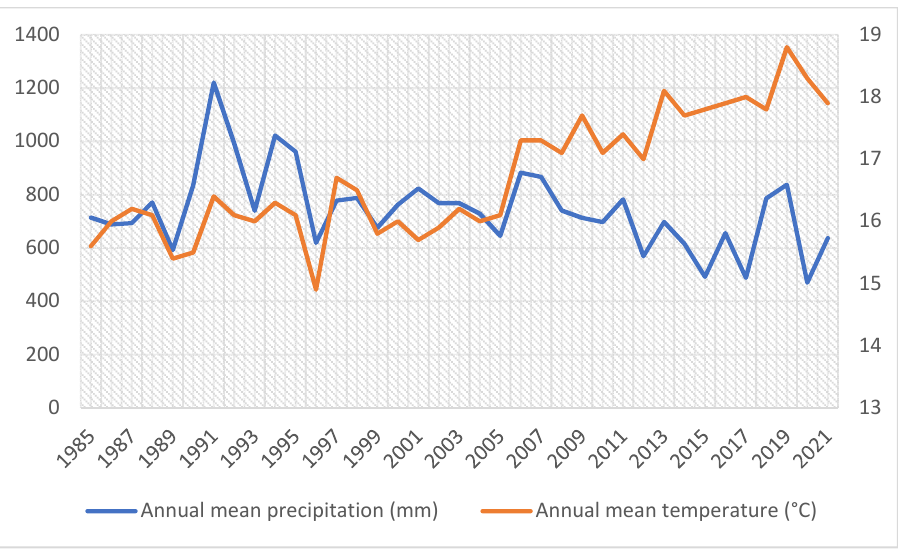
Figure 5. Graph of historical data on annual mean precipitation and annual mean temperature of Mexico City.